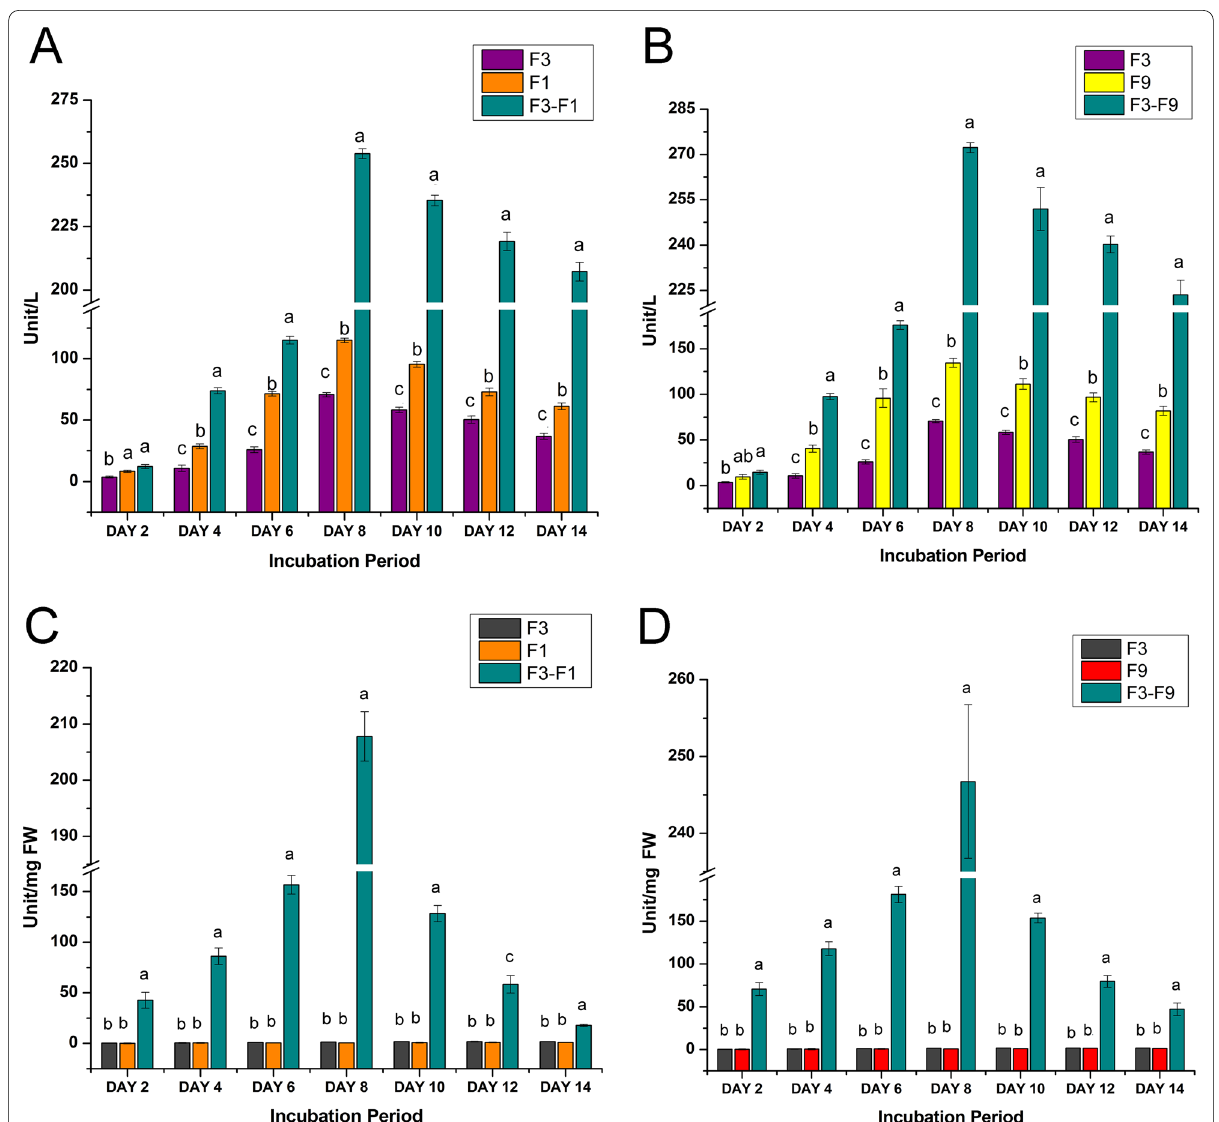
Fig. 6 Quantitative analysis for enzyme production. A Laccase production by T. coccinea (F3), T. versicolor (F1) and their interaction (F3–F1). B Laccase production by T. coccinea (F3), L. lactinea (F9) and their interaction (F3–F9). C SOD production by T. coccinea (F3), T. versicolor (F1) and their interaction (F3–F1). D SOD production by T. coccinea (F3), L. lactinea (F9) and their interaction (F3–F9) (level of significance with p